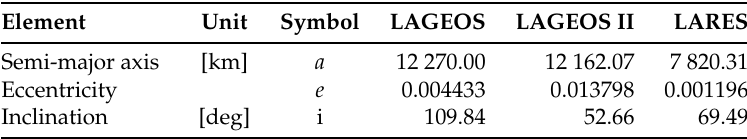
Table 3. Mean orbital elements of LAGEOS, LAGEOS II and